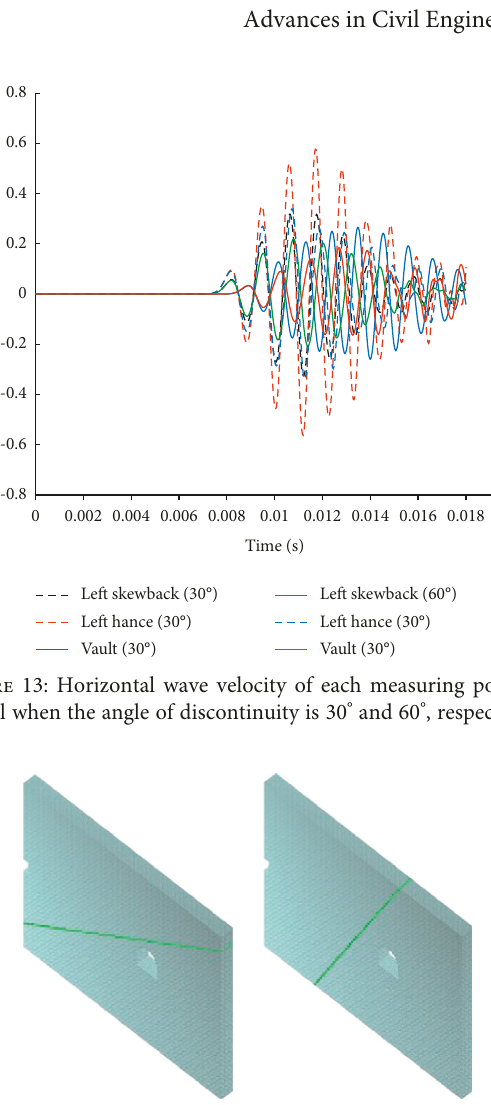
Figure 14: Schematic diagram of the model with 30 ° and 60 ° discontinuity